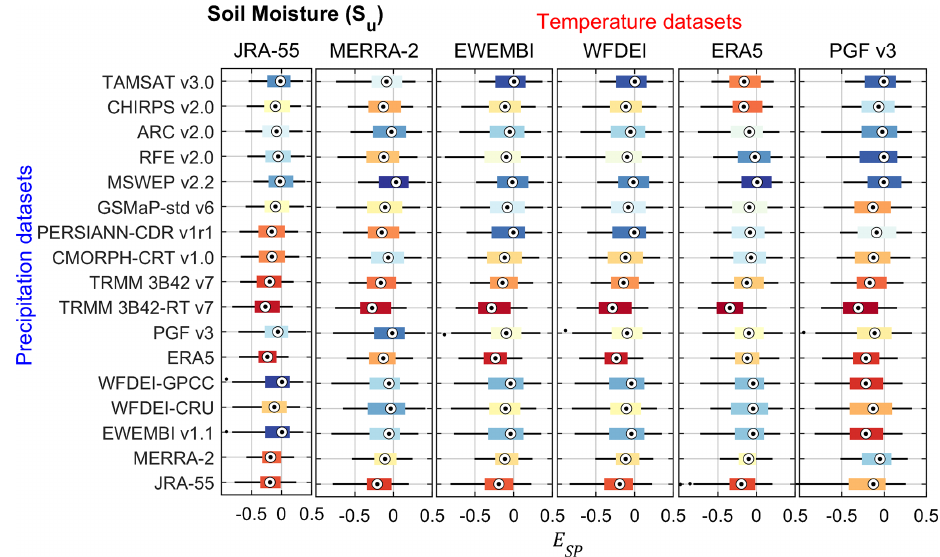
Figure 7. Spatial pattern efficiency ( E SP ) of soil moisture ( S u ) over the entire simulation period (2003–2012) for the Volta River basin (VRB) using different combinations of precipitation and temperature datasets as input for hydrological modelling. Each boxplot has 120 values, corresponding to the number of months. The boxplots are coloured from the best (blue) to the worst performance (red) based on the median value.